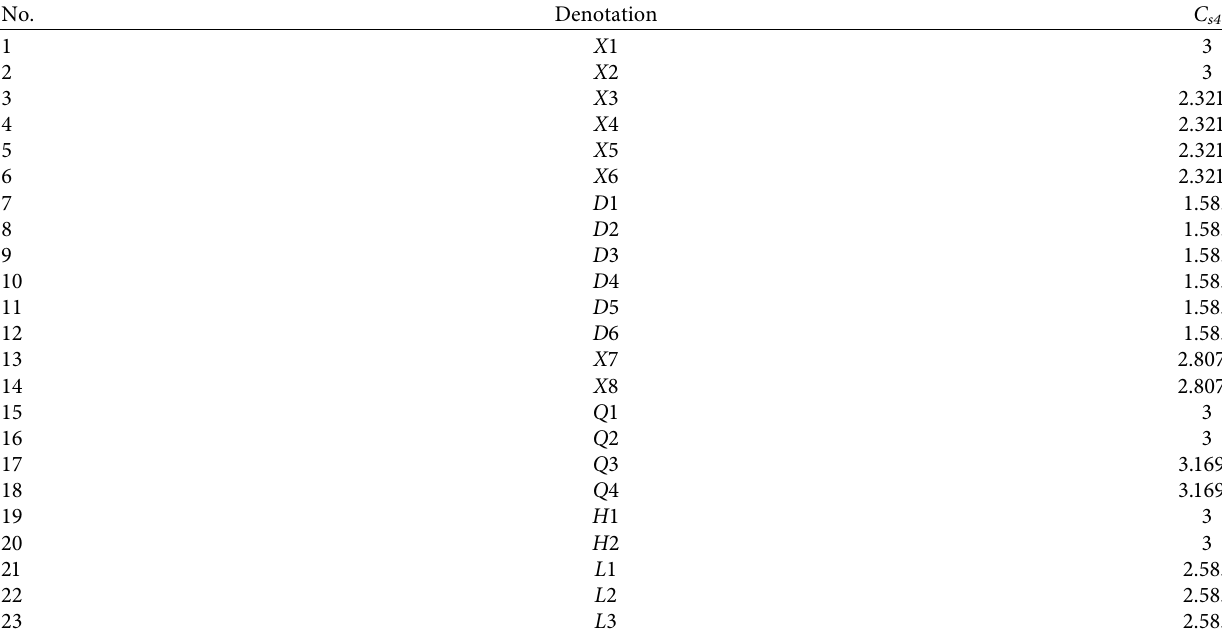
Figure 7: Manufacturing process chain of group A in women’s clothing workshop. Table 6: Static complexity of cut